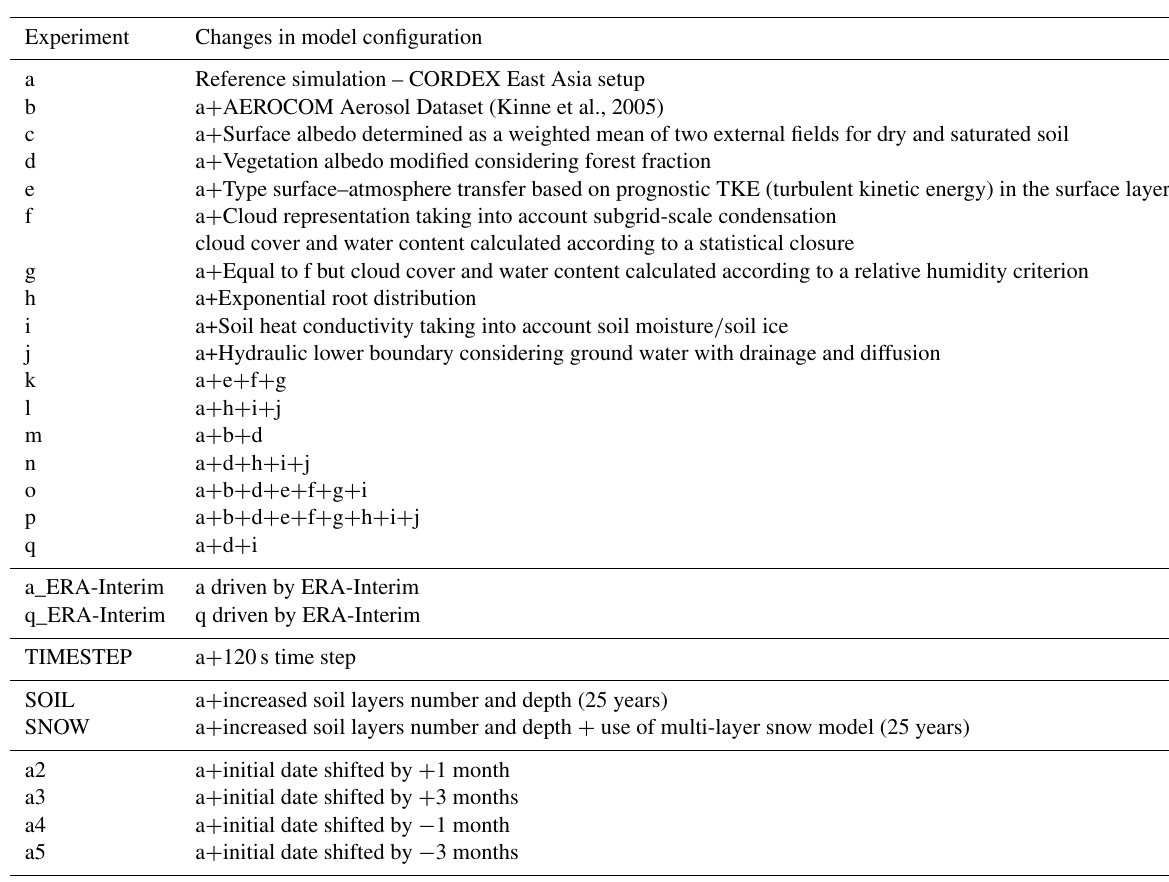
Table 1. List of performed experiments and their corresponding configuration. Experiment Changes in model configuration